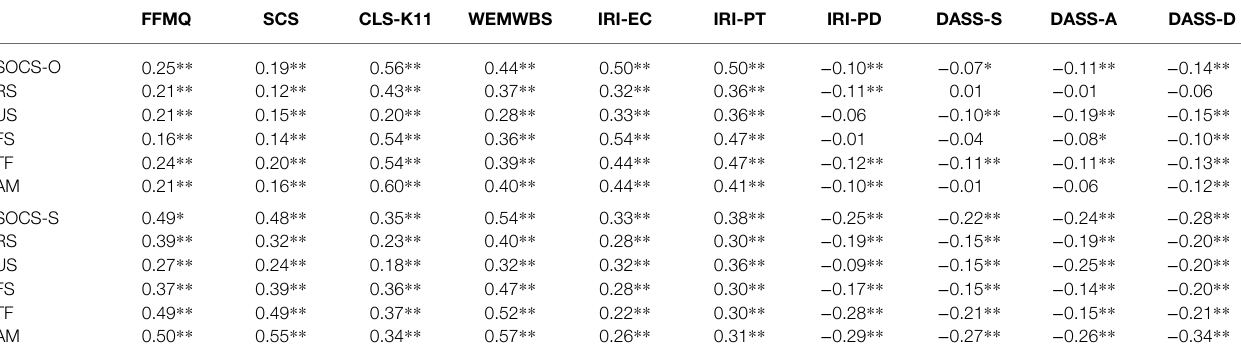
TABLE 3 | Correlation coefficients between total scores on the SOCS-O and SOCS-S and other self-report measures. FFMQ SCS CLS-K11 WEMWBS IRI-EC